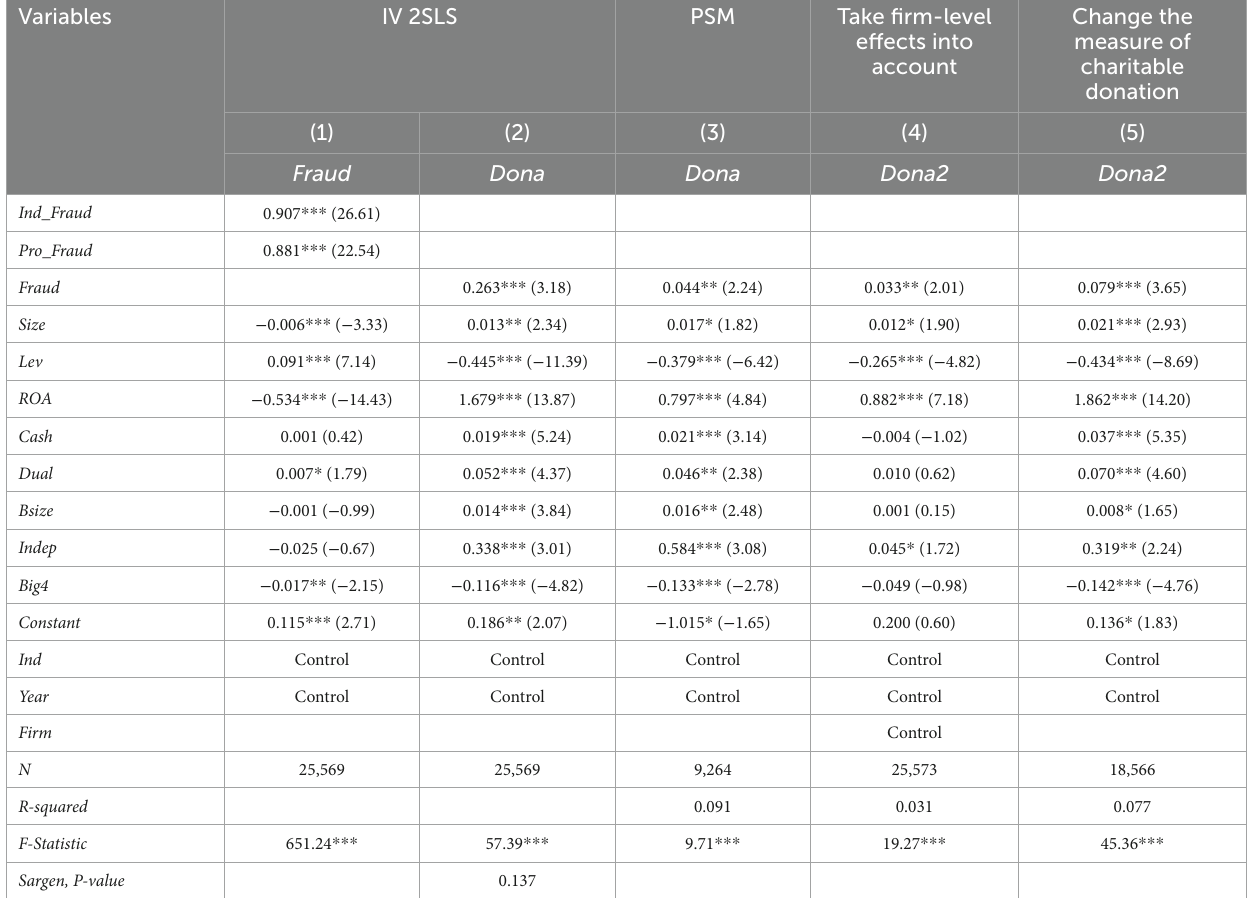
TABLE 5 Corporate violation and charitable donation: robustness test regression results.